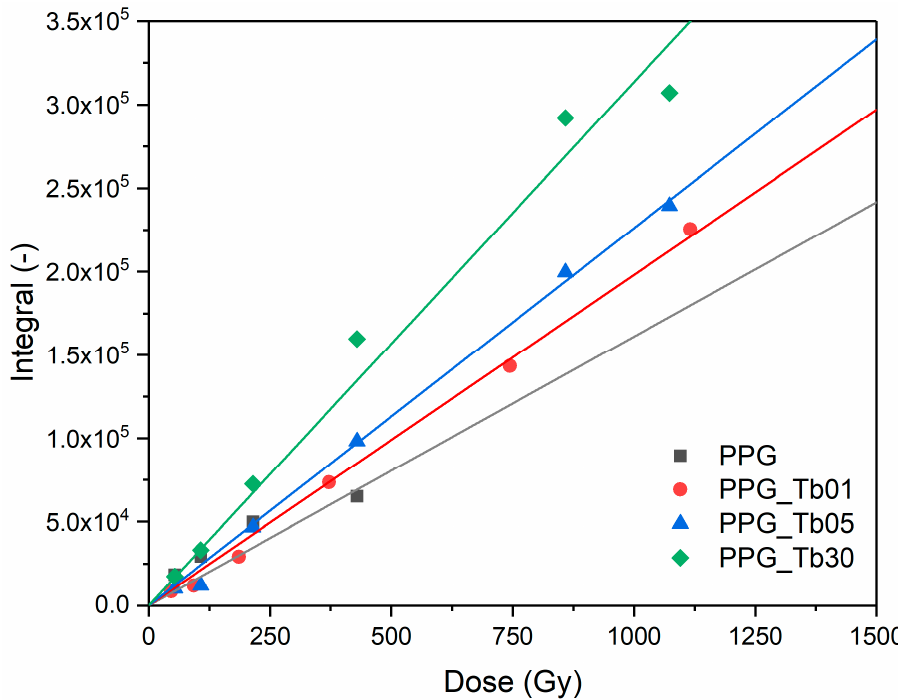
Figure 5. Dependencies of TL signal integral vs. dose absorbed for glass dosimeter irradiated with beta radiation (17ns); for PPG sample, TL glow curves were recorded without shutter. Table 3. Parameters of fitted linear functions for glass samples (radiation dose 50–2000 Gy).